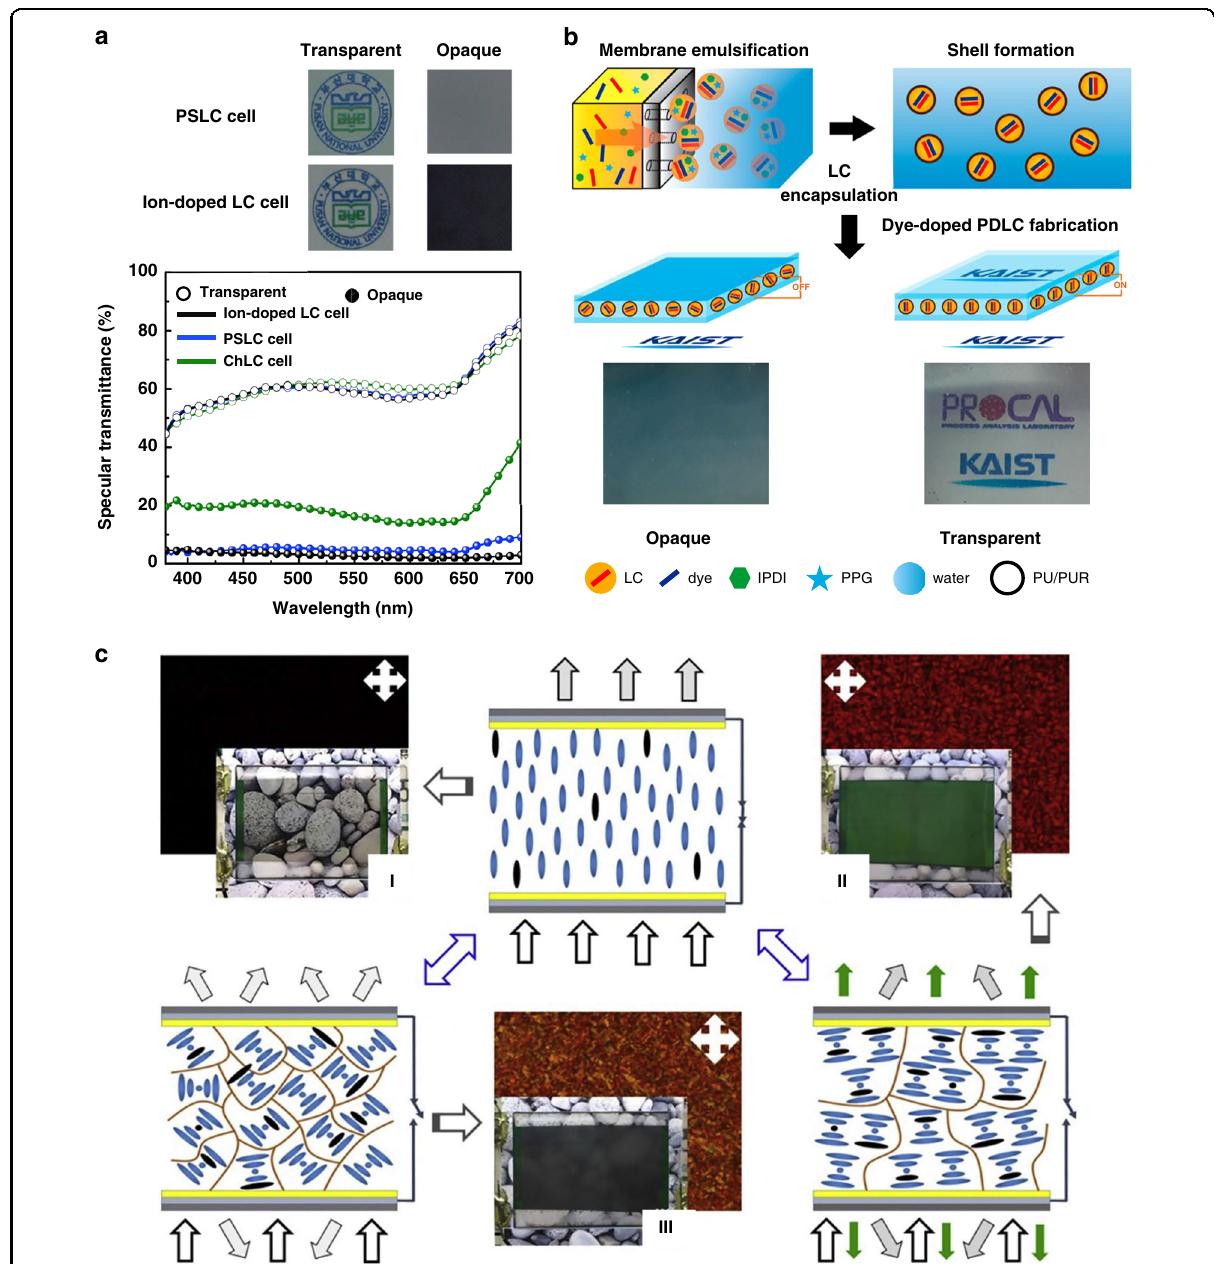
Fig. 15 Light protection strategies for other optical windows on vehicles. a Comparison of the transmission characteristics of PSLC and ion- doped LC cells. Reproduced with permission from ref. 86 . Copyright 2018, Elsevier. b PDLC preparation process to avoid dye contamination. Adapted with permission from ref. 172 . Copyright 2015, American Chemical Society. c When an electric fi eld was applied, the liquid crystals arranged vertically, and the device was in a transparent state (I). After the voltage was turned off, the CLCs were distributed in a plane, and the device re fl ected green light with a width of approximately 57 nm centered at 536 nm (II). In another case, the CLCs were arranged in a focal conic state, and the device was in a black fog state (III). Reproduced with permission from ref. 173 . Copyright 2019,